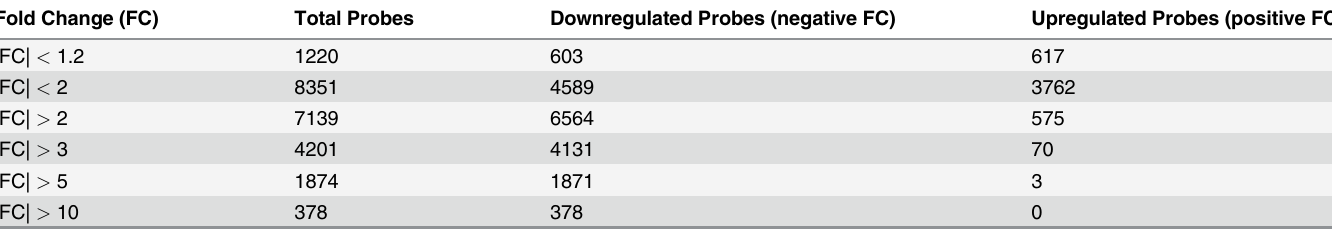
Table 2. Proportion of probes up or downregulated on